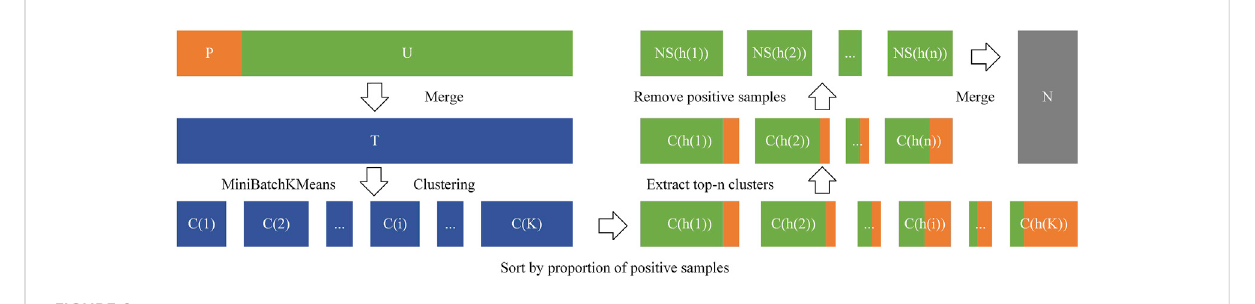
FIGURE 2 The method of constructing a negative sample